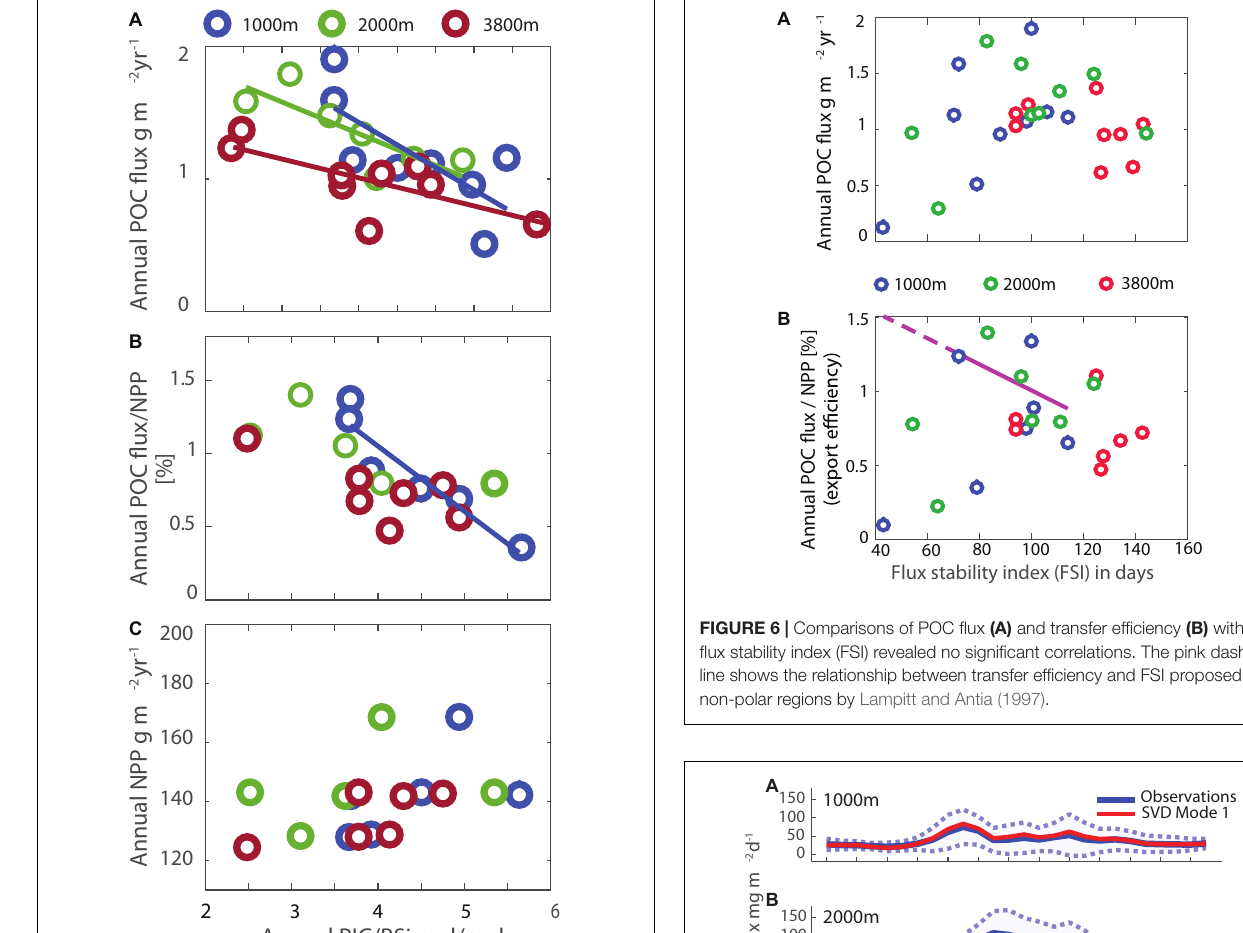
3800 m, with the other components showing smaller changes.